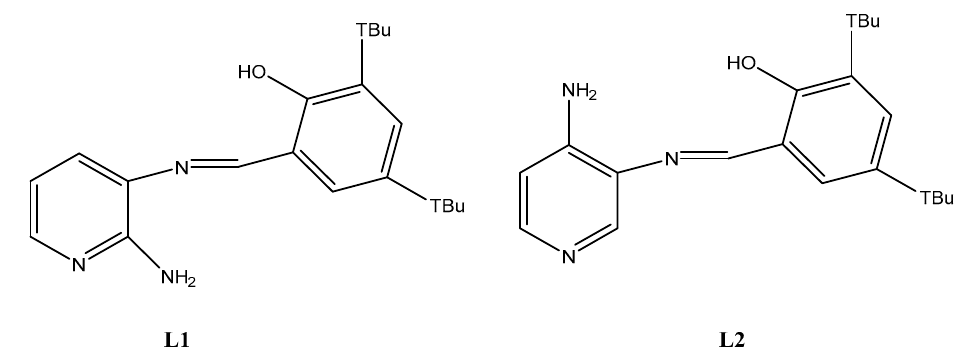
Figure 1. Chemical structure of ( E )-2-{[(2-aminopyridin-2-yl)imino]-methyl}-4,6-di- tert -butyl-phenol ( L1 ) and (( E )-2-{[(3-aminopyridin-4-yl)imino]-methyl}-4,6-di- tert -butyl-phenol) ( L2 ).